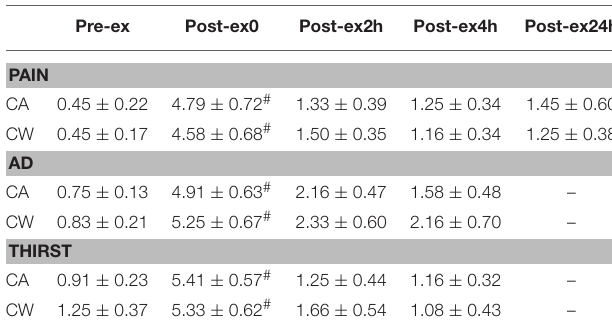
TABLE 2 | Muscle pain, abdominal discomfort, and thirst following treatments (M ± SE).